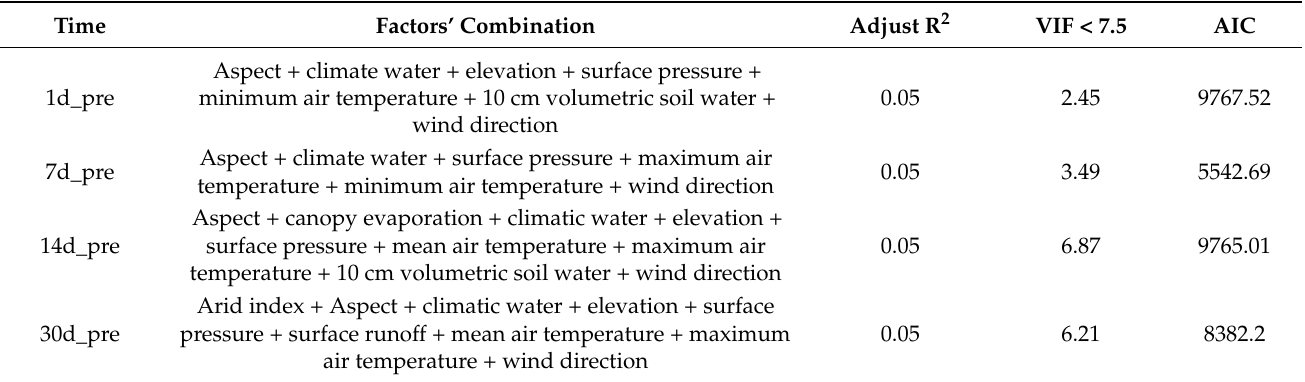
Table 2. Exploring results of fire-affected